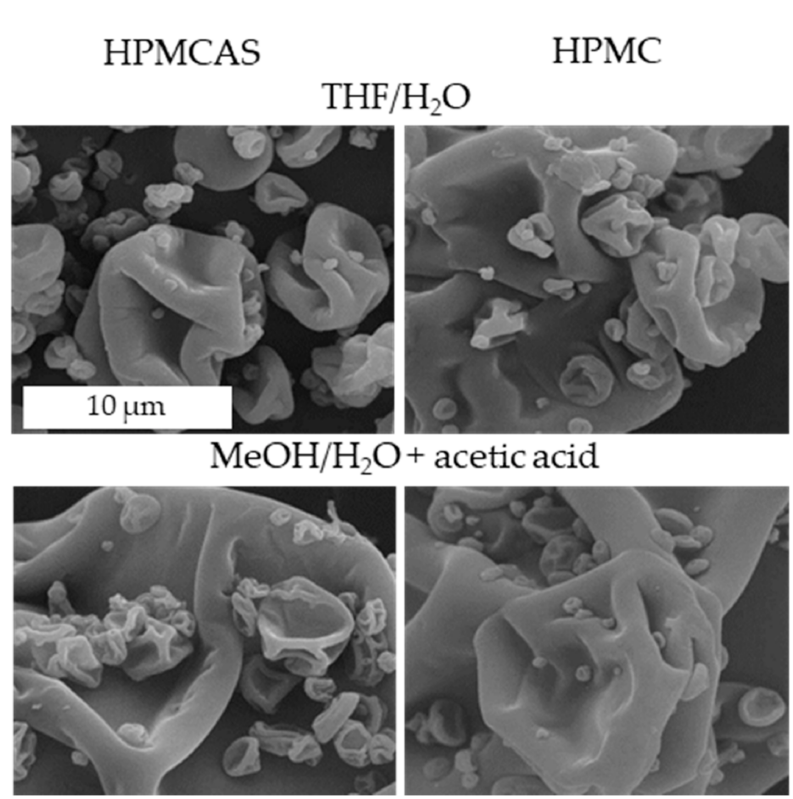
Figure 4. Representative SEM images of the 25% GEF SDDs with HPMCAS ( left ) and HPMC ( right ) standard SDDs ( top ) and acetic acid processing ( bottom ). The scale is the same for all